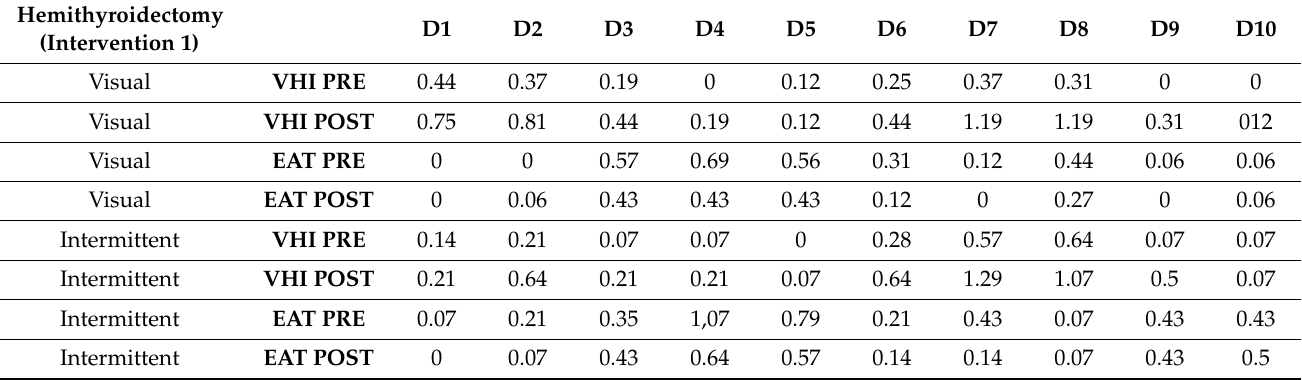
Table 2. Averages of the scores of the ten items in patients undergoing hemithyroidectomy and total